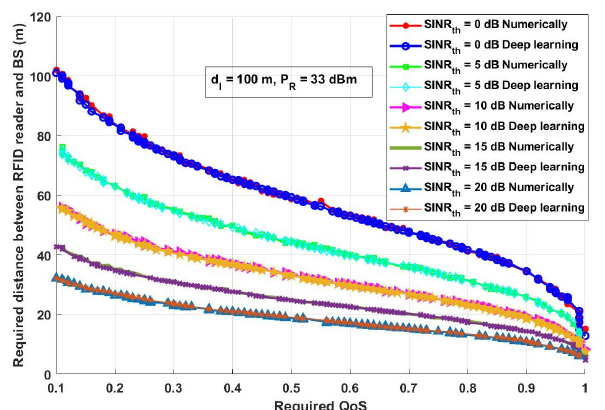
Figure 8. Required SINR th (dB) versus required distance between RFID and BS (m).